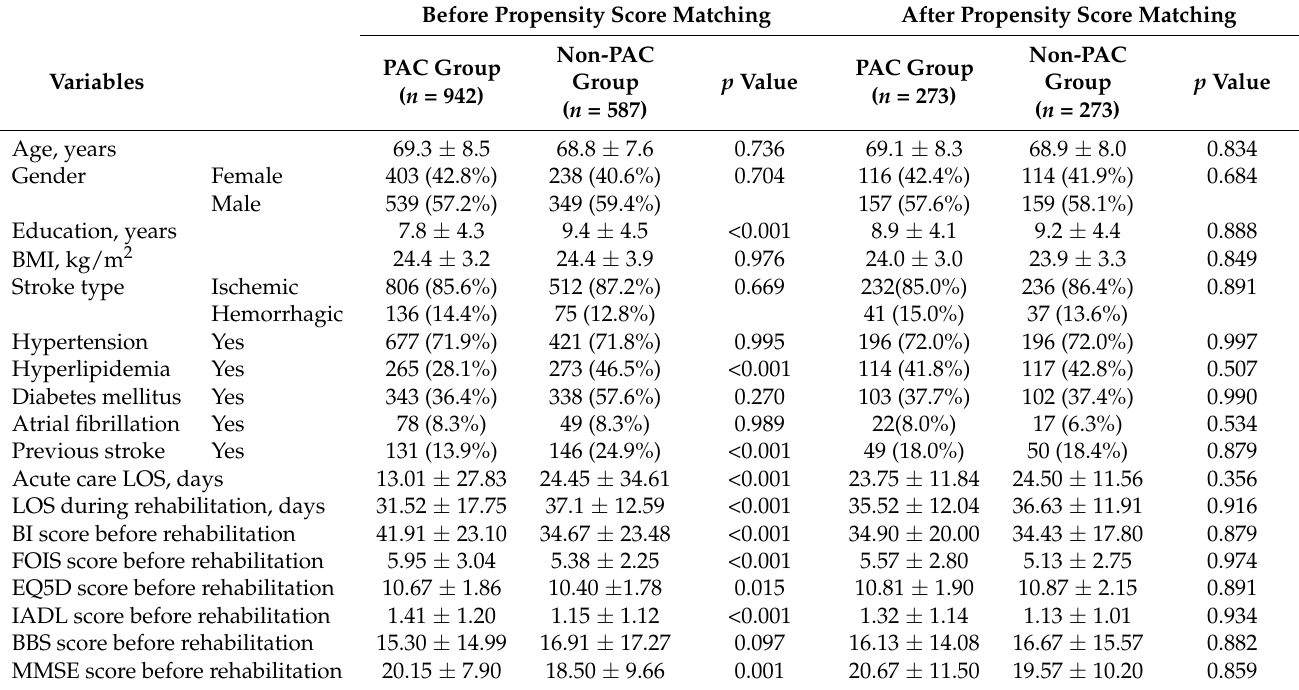
Table 1. Stroke patient